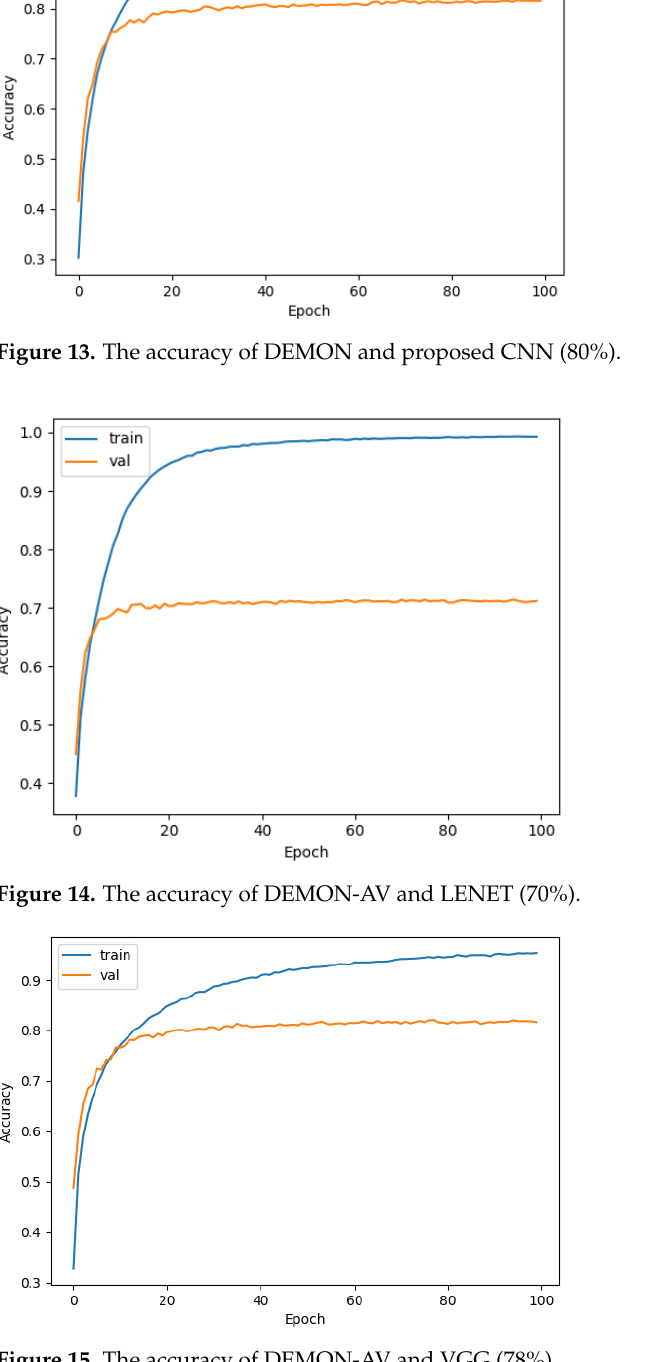
Figure 15. The accuracy of DEMON-AV and VGG